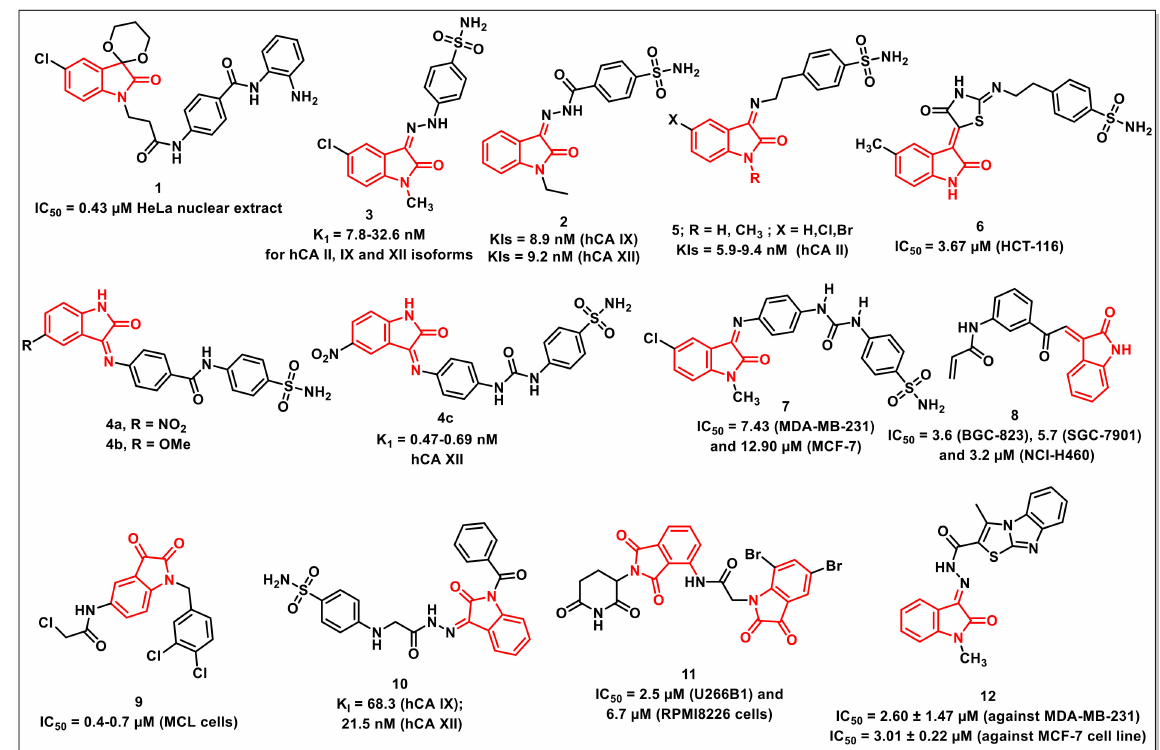
Figure 2. Amide- and sulphonamide-based isatin scaffolds with promising antiproliferative/ anticancer